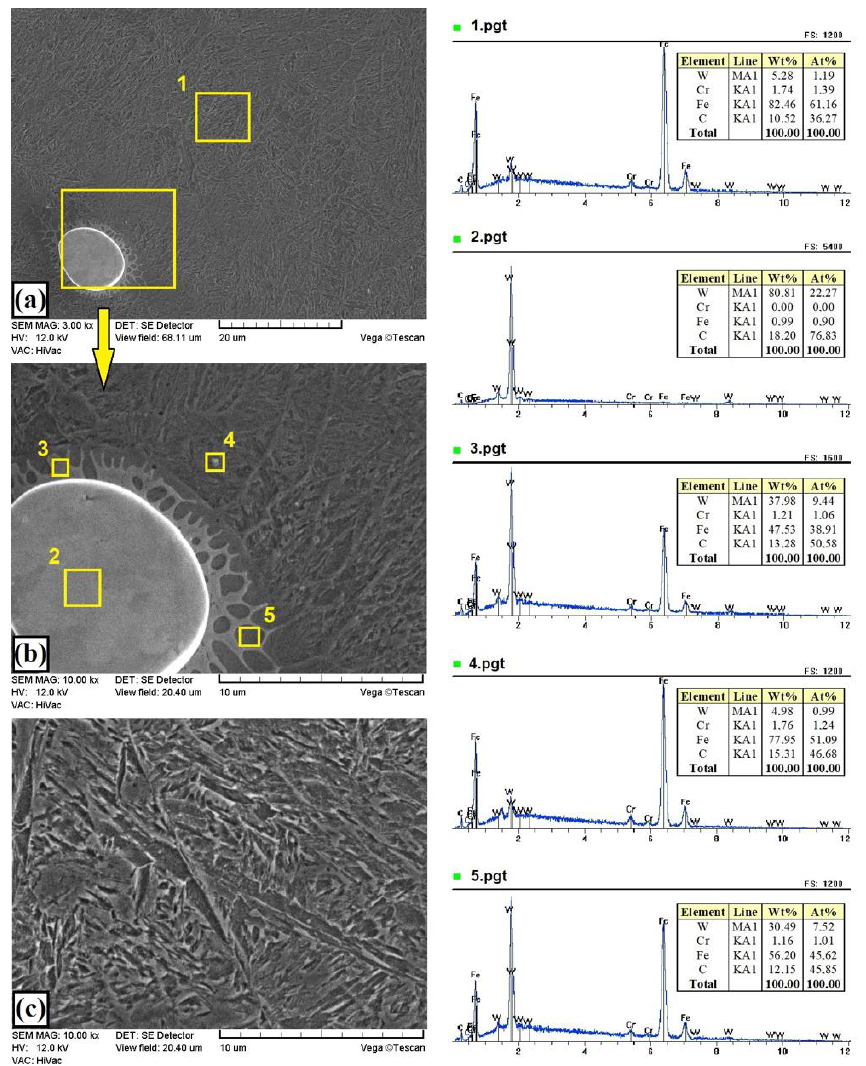
Figure 7. Microstructure and EDS point analysis of W–Cr coating reinforced with 50% WC particles produced using laser processing of precoat applied on steel substrate: ( a ) general view of the melting zone; ( b ) carbide-matrix interface; ( c ) matrix.